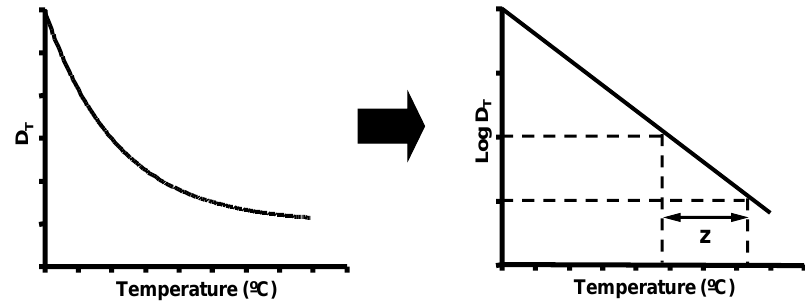
Figure 6. Influence of treatment temperature on the lethality of heat ( D T values).